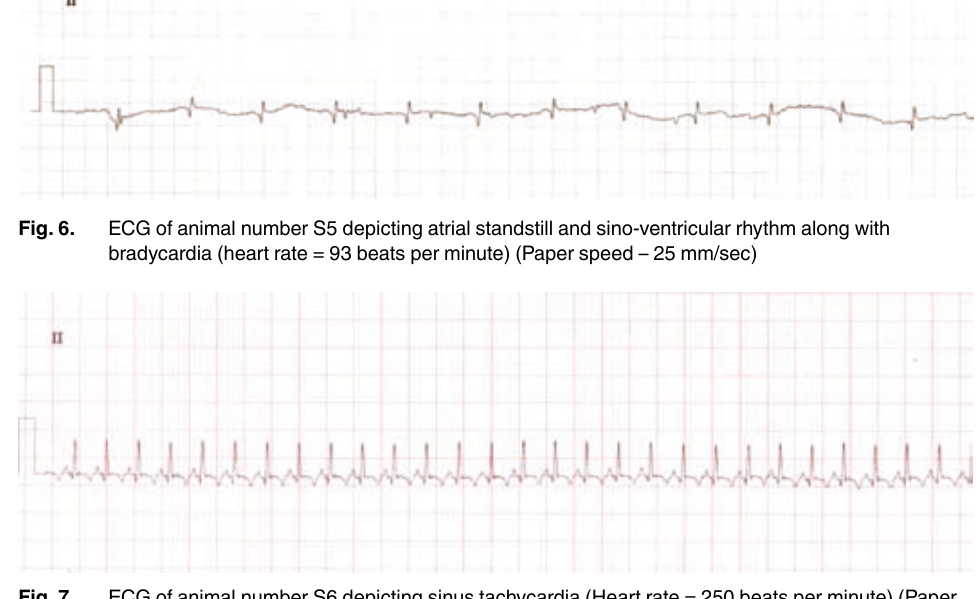
of the QT interval by prolongation of phase 2 of the cardiac action potential (Dusky,